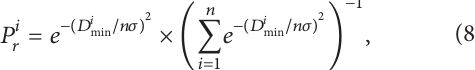
Figure 2: Size of the simulation space (unit: